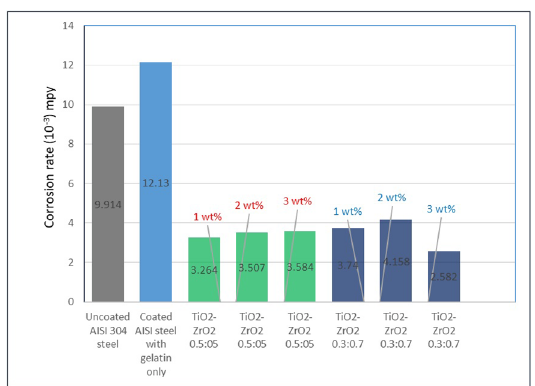
Figure 11 . Corrosion rate (10 -3 mpy) of the AISI 304 steel coated with hybrid TiO -ZrO coating with mix ratios 0.5:0.5, 0.3:0.7, and 2 2 different weight percentages (1% wt., 2% wt., 3% wt.) of nanoparticles dispersed in gelatin, as well the corrosion rate of the uncoated AISI 304 steel and the coated AISI 304 steel with gelatin only.